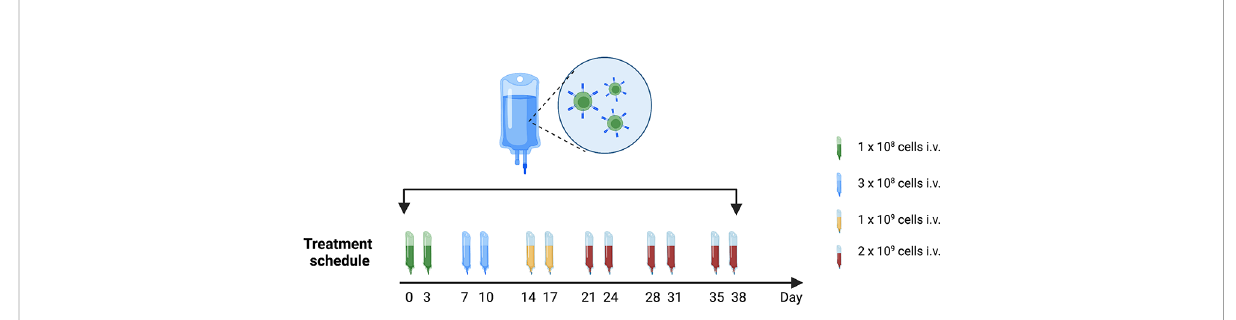
FIGURE 4 Treatment schedule with timing and doses of Radium-4 T cell infusions in the T-RAD study. Created using BioRender.com.